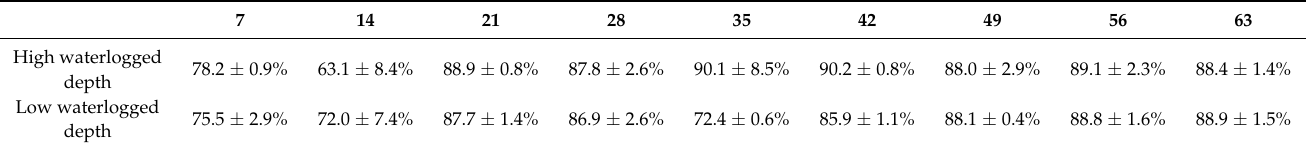
Table 3. Average removal rate of effluent total nitrogen under different waterlogged